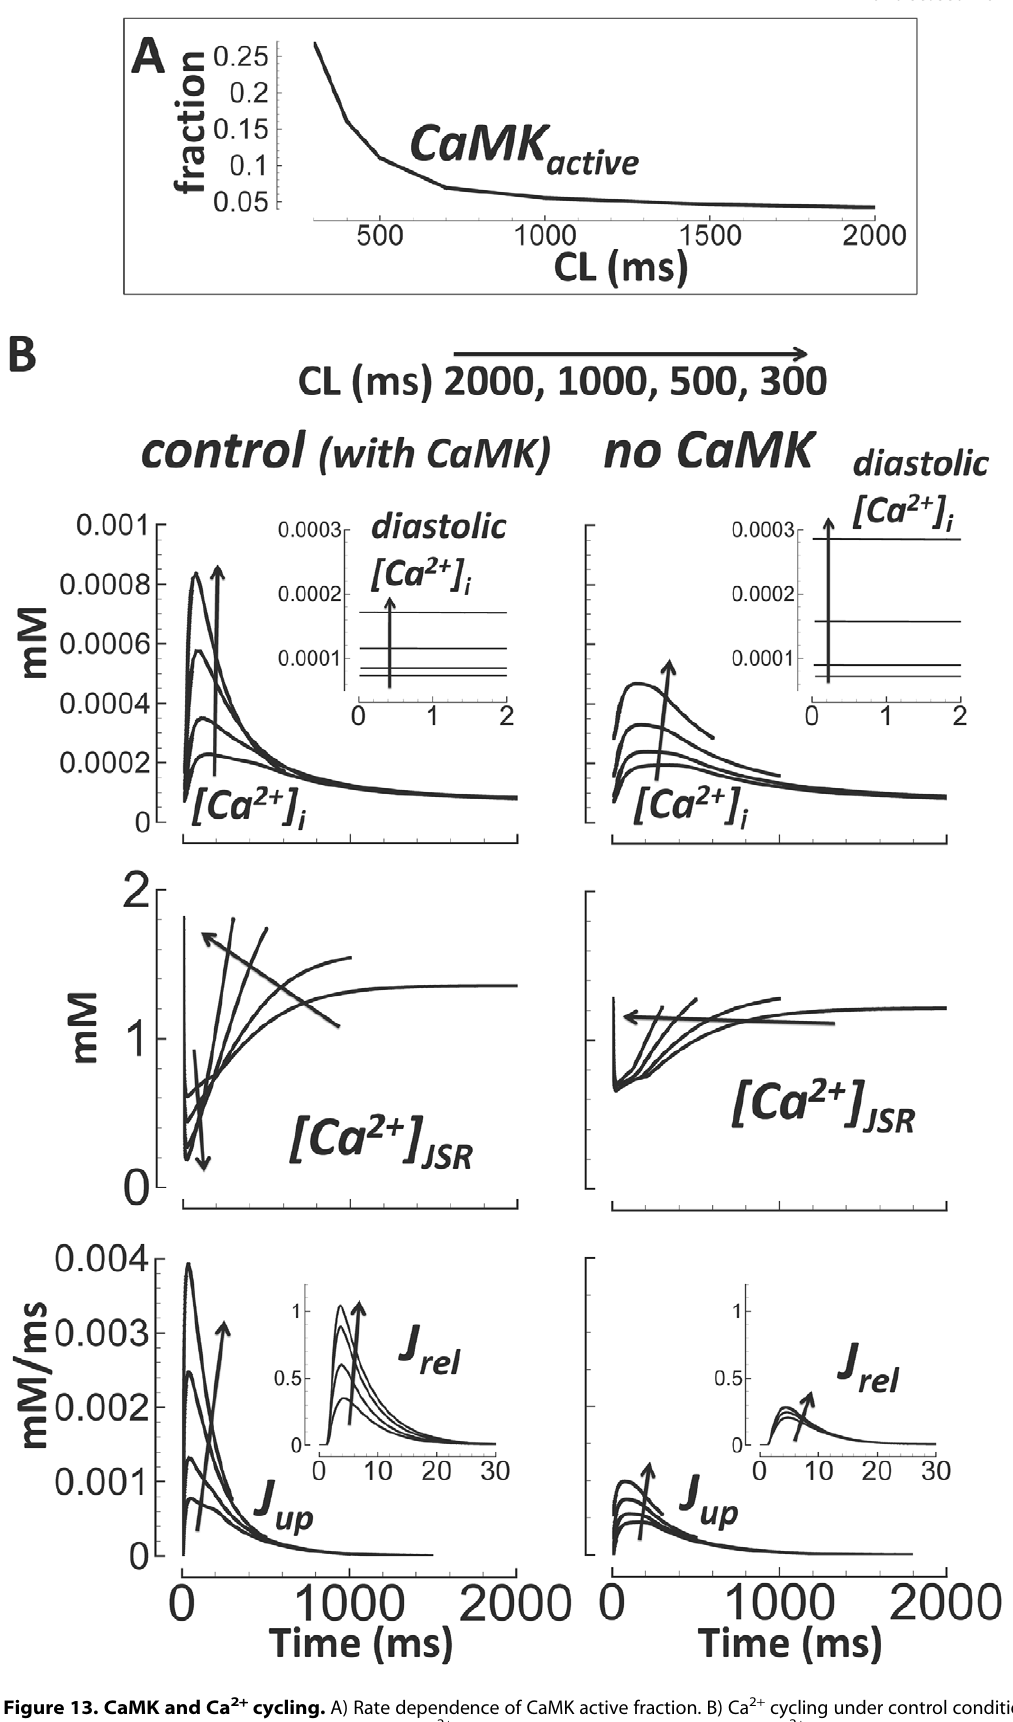
Figure 13. CaMK and Ca 2 + cycling. A) Rate dependence of CaMK active fraction. B) Ca 2 + cycling under control conditions (left) and without CaMK (right). CL changes are indicated by arrows. Top) [Ca 2 + ] i and diastolic values (inset). Middle) [Ca 2 + ] JSR . Bottom) J up and J rel (inset, expanded time scale). doi:10.1371/journal.pcbi.1002061.g013 PLoS Computational Biology |